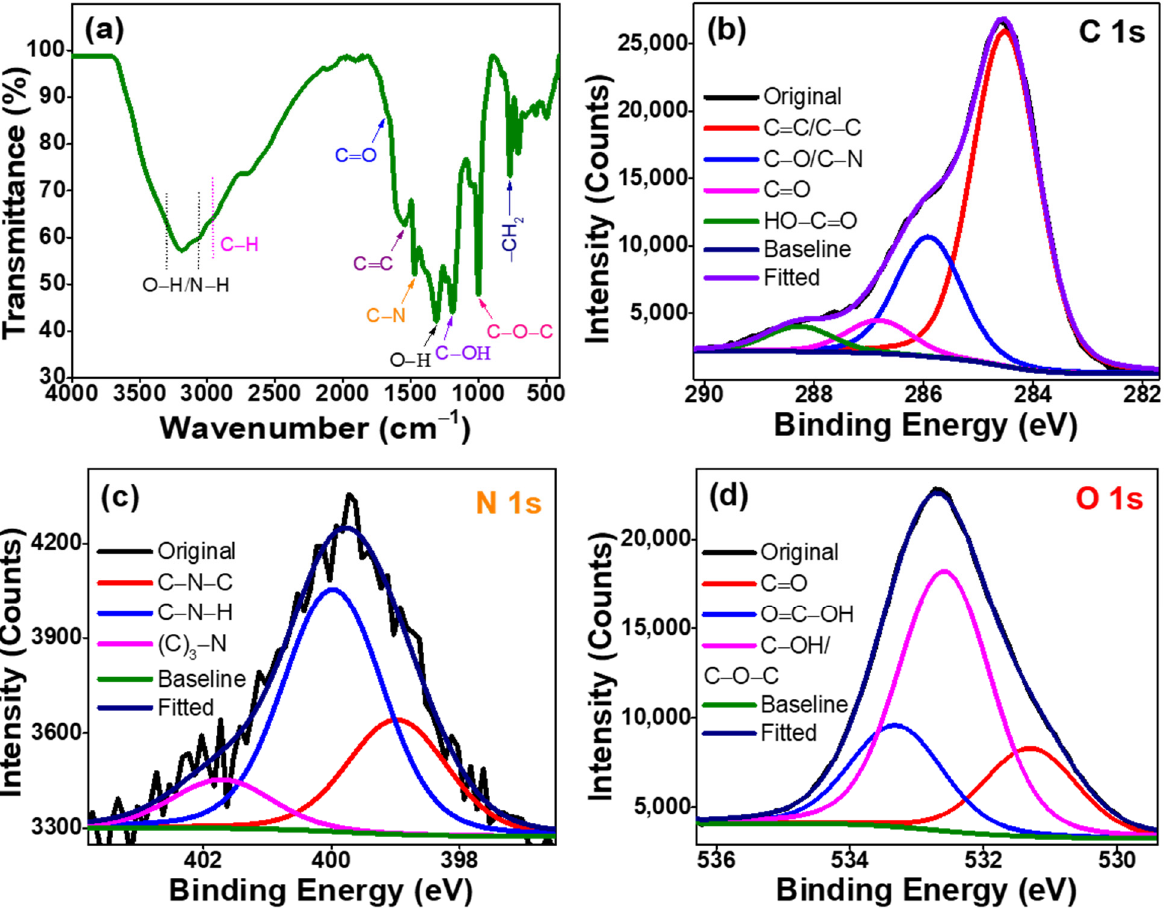
Figure 4. ( a ) ATR-FTIR spectrum of synthesized TC-CDs. XPS spectra of synthesized TC-CDs; ( b ) high-resolution spectrum of C 1s, ( c ) high-resolution spectrum of N 1s, and ( d ) high-resolution spectrum of O 1s levels with deconvolution.